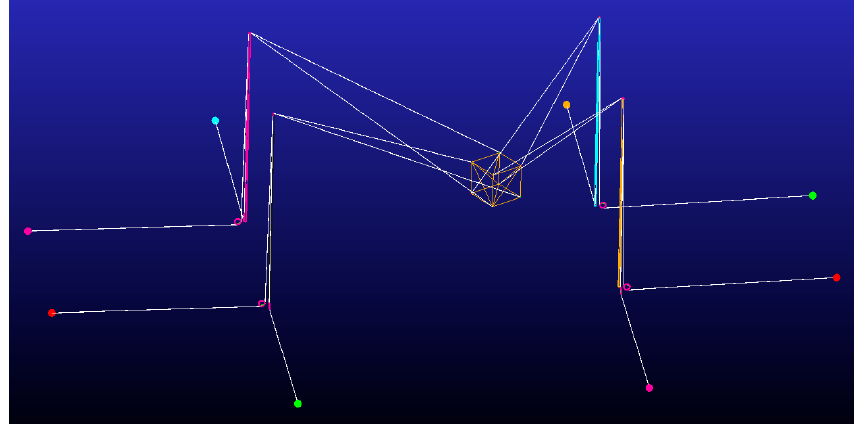
Figure 17. Dynamic multibody model tested in MSC ADAMS. Table 4 defines the robot dimensions and configuration. Cables are actuated by pulling from their ends situated in the basement. Those cables have to pass around two pulleys, one situated in the pillar base and the other in the top of the pillar.